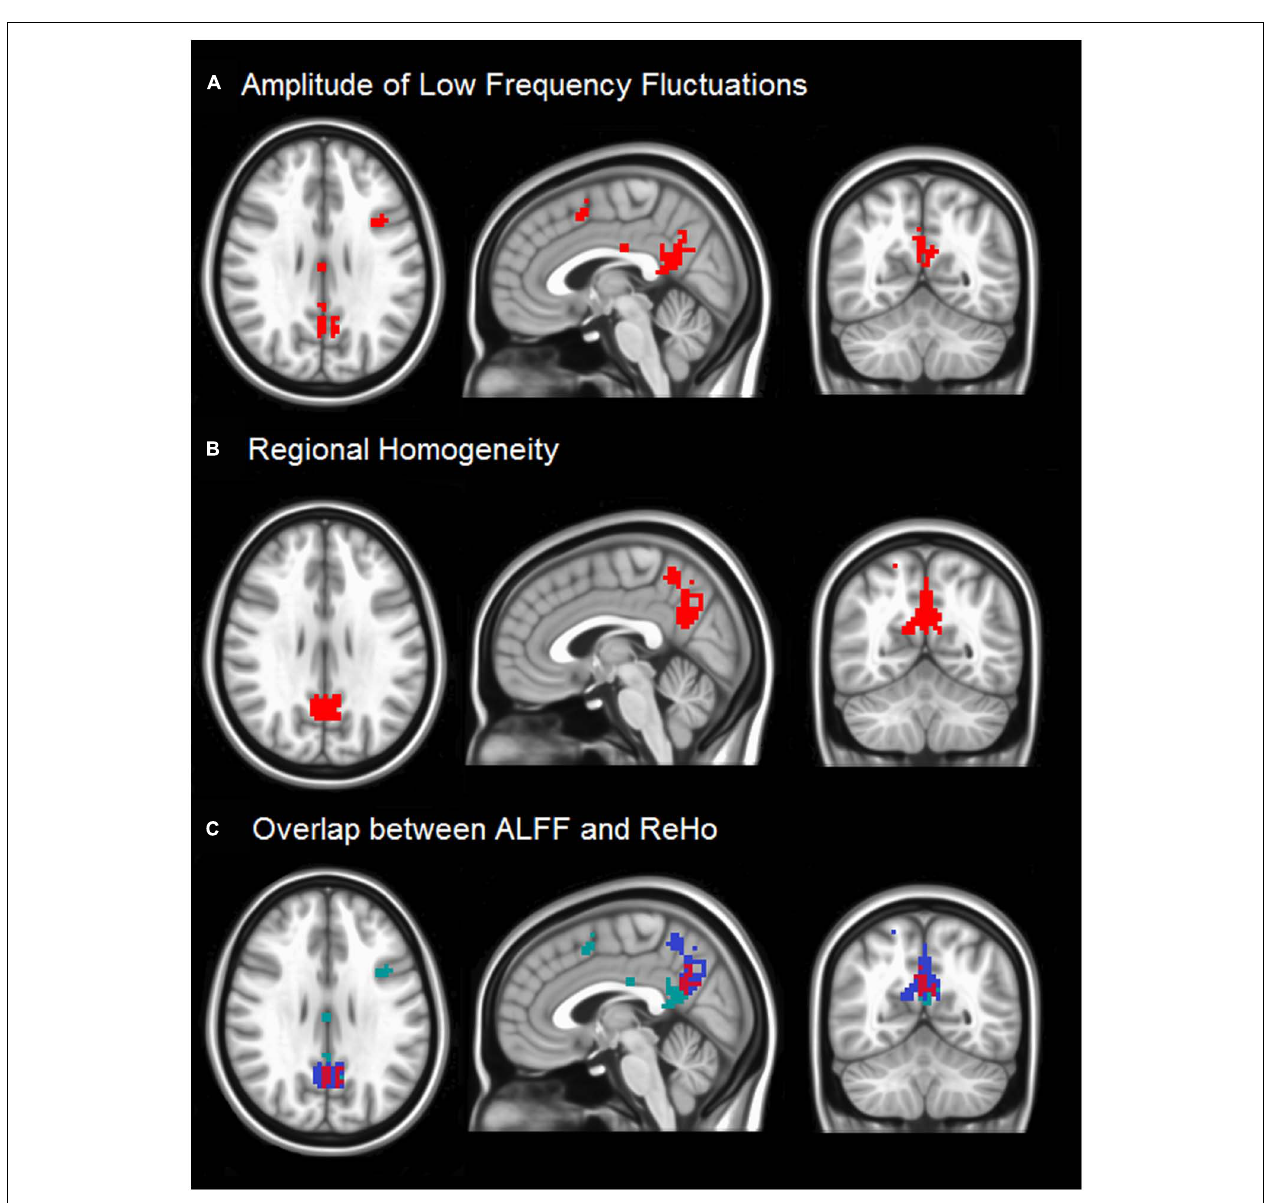
FIGURE 1 | (A) The two sample t -test result of ALFF between two groups with the threshold at corrected p < 0.05 is shown.The regions around PCC (highlighted in red) indicate that stroke patients with impaired consciousness have lower ALFF than matched normal controls. (B) Two sample t -test results of ReHo between two groups at p < 0.05 is shown.The results were